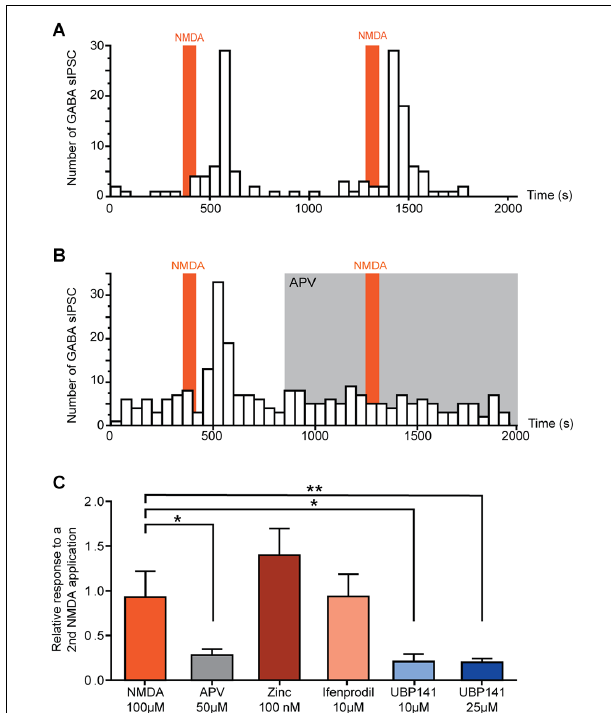
FIGURE 2 | Activation of GluN 2C/D containing NMDA receptors induces increase of spontaneous GABAergic transmission. (A,B) Example of the effect of two successive NMDA applications on the number of GABAergic sIPCSs (50 s bin). NMDA effect is reproducible (A) and completely blocked in presence of APV (50 µ M) (B) . (C) Effect of a second application of NMDA in presence of different NMDAr selective antagonists. Histogram showing the effect of a second NMDA application normalized to a first application performed in absence of antagonists. NMDA-induced increase in GABA sIPSC frequency was inhibited in presence of APV (50 µ M, N = 8) and UBP 141 (10 µ M, N = 4; 25 µ M, N = 9). Presence of Zinc (100 nM, N = 4) or Ifenprodil (10 µ M, N = 8) did not affect NMDA effect. * p < 0.05 and ** p < 0.01. Mann-Whitney test was used. Error bars indicate